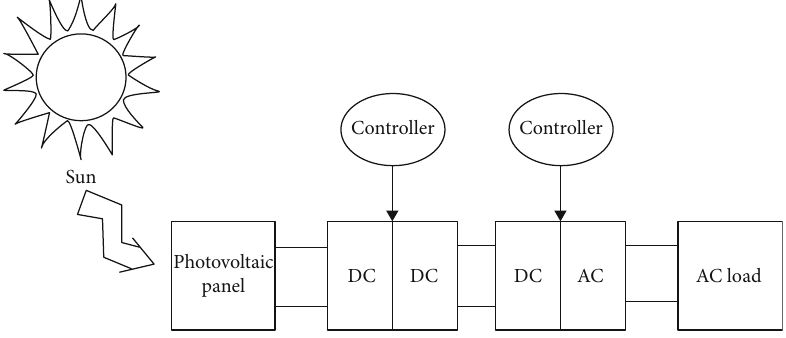
Figure 1: Stand-alone photovoltaic